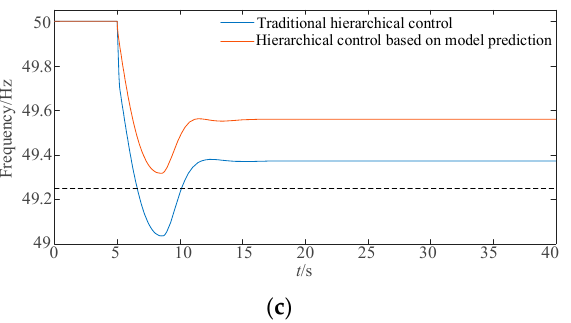
Figure 9. Comparison of effects of hierarchical control strategies. ( a ) Strategy comparison when the